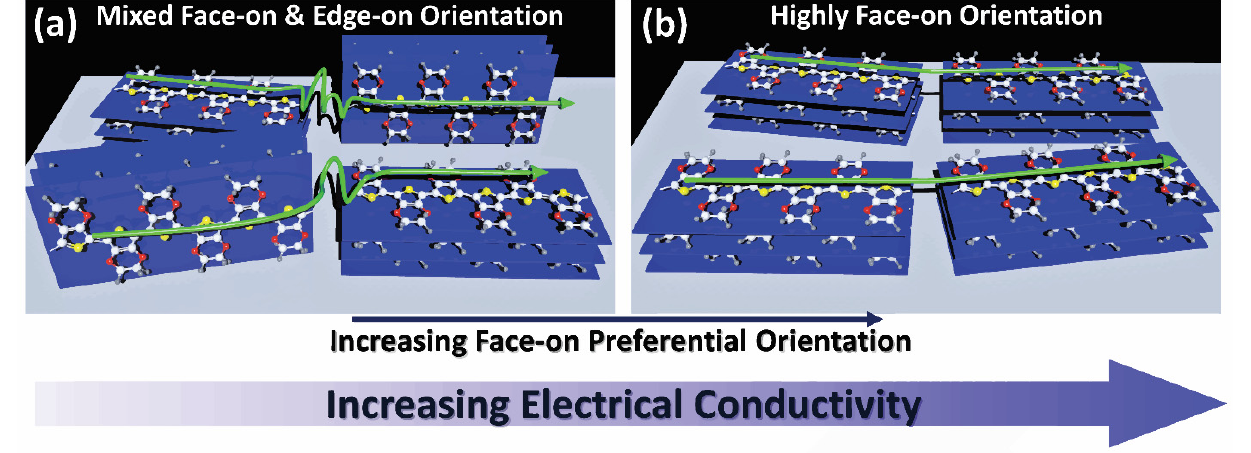
Figure 11. Schematic illustration of ( a ) a mixture of face ‐ on and edge ‐ on orientations and ( b ) a highly face ‐ on orientation in conjugated conducting polymers [18]. A mixture of face ‐ on and edge ‐ on orientations can be transferred to a more desirable orientation for improving the in ‐ plane conductivity (a highly face ‐ on orientation) by tuning the process parameters. ( a , b ) Reproduced with permission [18]. Copyright 2020,